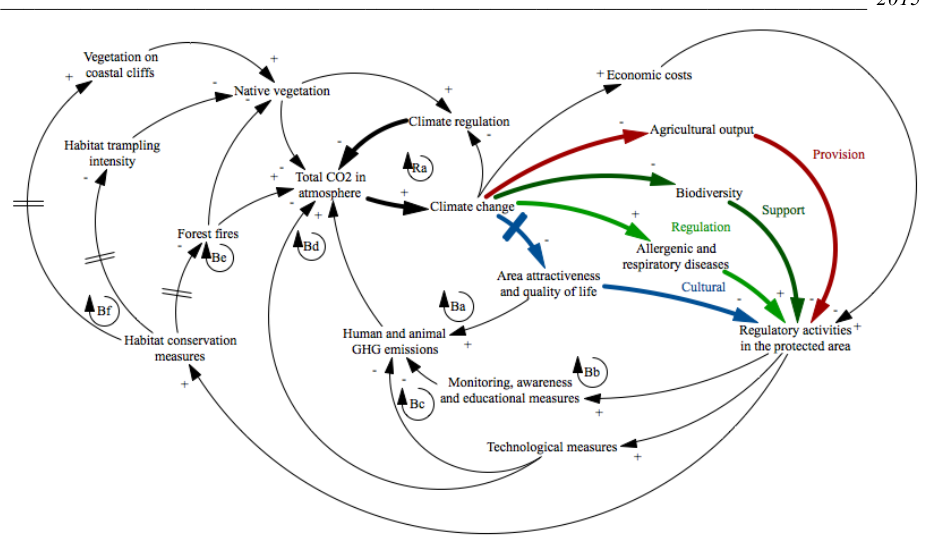
Fig. 5. Causal loop diagram highlighting the links among different categories of ecosystem